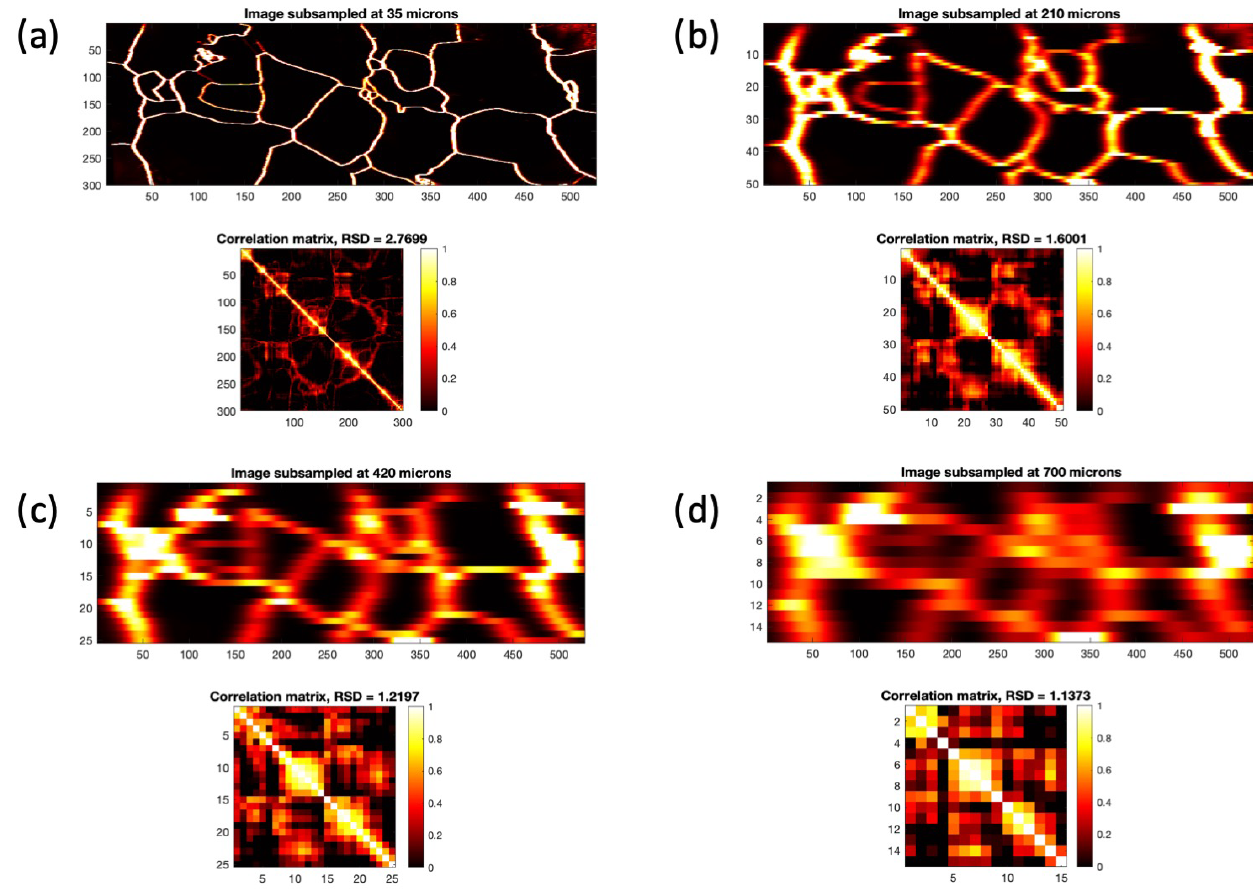
Figure 9. Same as Fig. 7 but for the EDC MIS 5.5